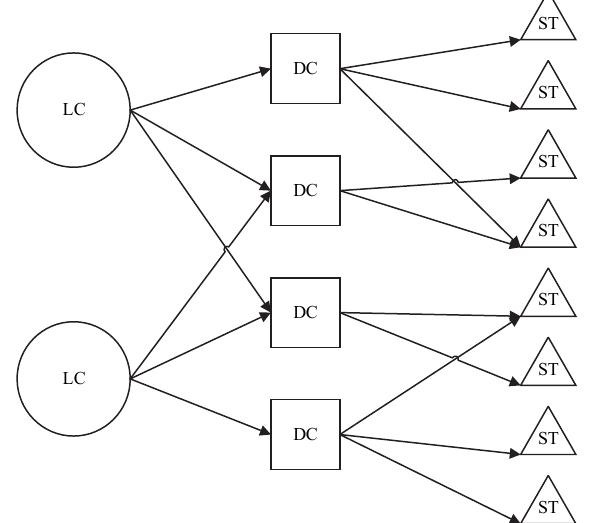
Fig. 1. City logistics distribution network (Teimoury et al.,